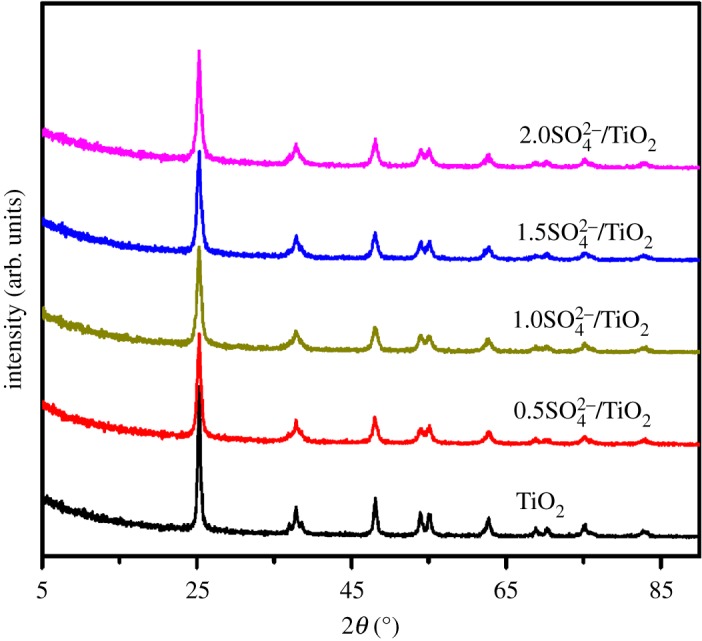
XRD diffraction patterns of the TiO2 and SO42−/TiO2 samples.